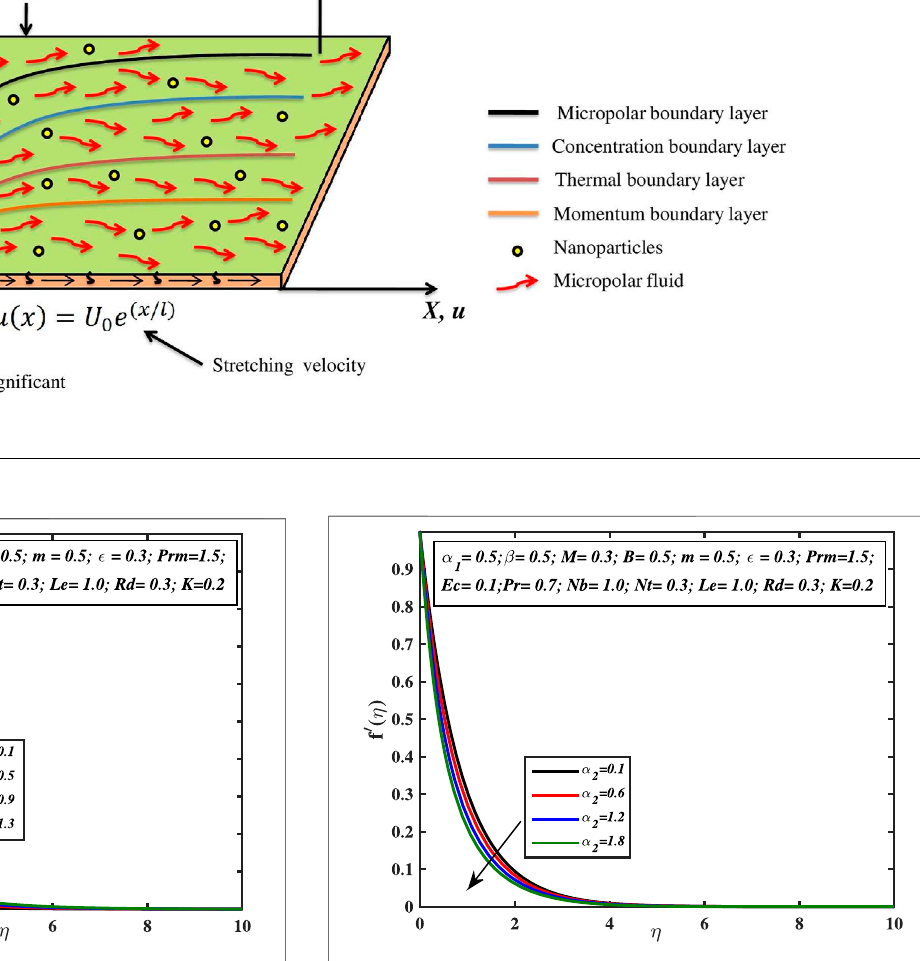
FIGURE 2 | Effect of α 1 on the velocity curve. FIGURE 3 | Effect of α 2 on the velocity